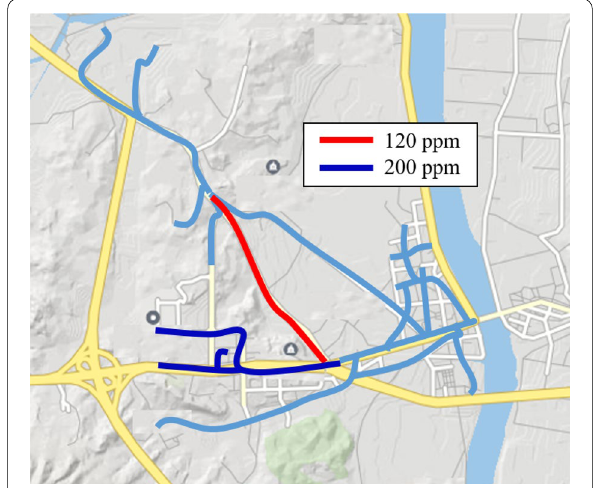
Fig. 3 Sewage pipelines in district